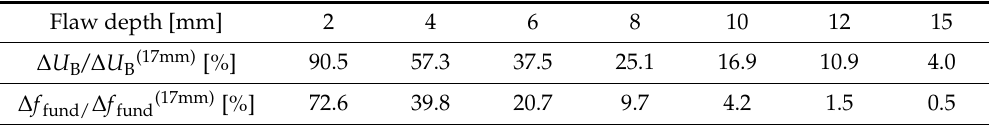
Table 2. Comparison of relative changes in the signal value for various defects in relation to the defect with a depth of 17